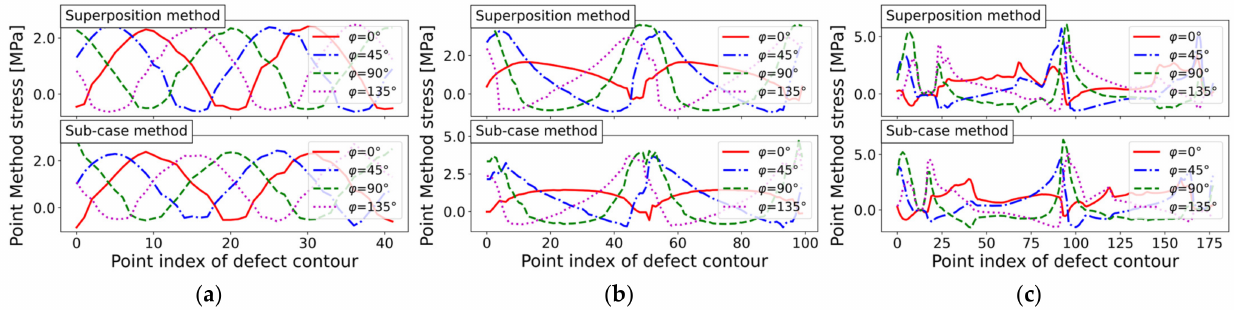
Figure 20. TCD Point Method stress course for three defect geometries at evaluation arc-length L m = a 0 /2 = 0.113 mm and incremental load step of ∆ ϕ = 10 ◦ : ( a ) Circular hole-in-plate (mesh ‘circle_lin_R1mm_v1’); ( b ) Elliptical hole-in-plate (mesh ‘ellipsis_lin_rot0deg_v1’); and ( c ) Elongated defect (mesh ‘defect_elongated_lin_v1’).